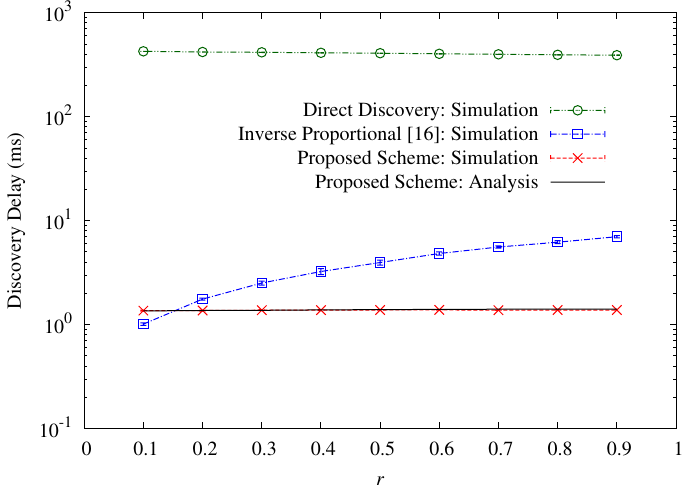
Figure 7. Discovery delay of different